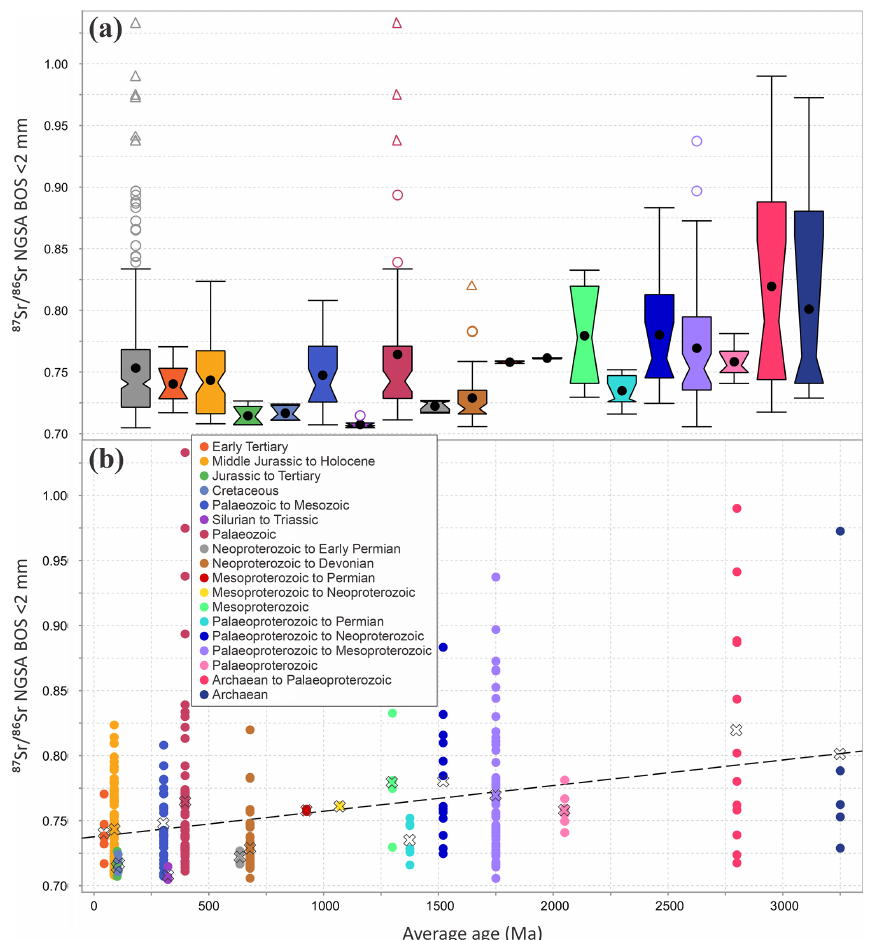
Figure 6. Distribution of the 87 Sr / 86 Sr data from the northern Australia Sr isotope study area by geological region age: (a) notched Tukey box plots (Tukey, 1977) of, left to right, the whole dataset first (grey; n = 357) and then sorted by average age (early Tertiary, n = 6; Middle Jurassic to Holocene, n = 80; Jurassic to Tertiary, n = 5; Cretaceous, n = 4; Palaeozoic to Mesozoic, n = 28; Silurian to Trias- sic, n = 6; Palaeozoic, n = 61; Neoproterozoic to early Permian, n = 7; Neoproterozoic to Devonian, n = 49; Mesoproterozoic to Permian, n = 2; Mesoproterozoic to Neoproterozoic, n = 2; Mesoproterozoic, n = 4; Palaeoproterozoic to Permian, n = 7; Palaeoproterozoic to Neo- proterozoic, n = 13; Palaeoproterozoic to Mesoproterozoic, n = 59; Palaeoproterozoic, n = 7; Archaean to Palaeoproterozoic, n = 12; and Archaean, n = 5); (b) a scatterplot against the average age of the geological region with the group averages (crosses) and linear square regression line (dashed